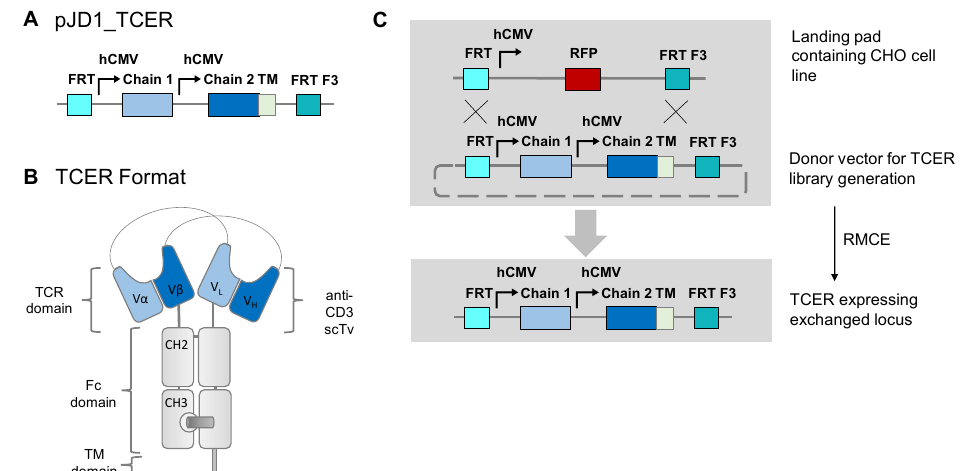
Figure 4. Vector design and overview of RMCE-mediated process for TCER library generation in CHO cells. ( A ) pJD1_TCER donor vector with hCMV promotor-driven expression cassettes for TCER chain 1 and 2, which are flanked by a 5 ′ FRT and a 3 ′ FRT F3 site. ( B ) Molecular structure of a TCER molecule. TCER chain 1 encodes for the variable TCR alpha chain (V α ), the variable light chain (VL) of an UCHT1 anti-CD3 antibody followed by IgG1 constant domains CH2 and CH3 modified with specific mutations to ablate Fc gamma receptor binding and complement activation as well as knob-forming mutations. The CH3 domain is followed by a PDGFR transmembrane domain for anchoring the TCER molecule on the CHO cell surface. TCER chain 2 encodes for the variable heavy chain (VH) of the anti-CD3 antibody and the variable TCR beta chain (Vb) followed by IgG1 constant domains CH2 and CH3 modified with specific mutations to ablate Fc gamma receptor binding and complement activation as well as hole-forming mutations. ( C ) RMCE process for TCER library generation in CHO cells. The RFP locus of the RFP_A03 CHO cells was exchanged via RCME with TCER containing donor vectors encoding for all potential combinations of CDR variants (see also Table 2) of a PRAME-specific model TCR.